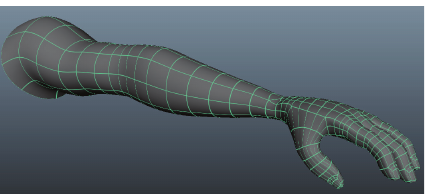
Figure 2: The arm model.